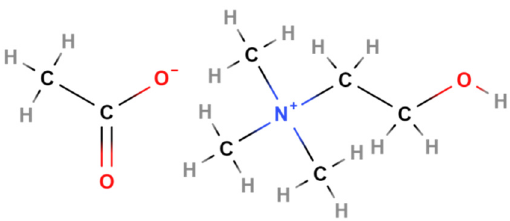
Figure 1. Chemical structure of 2-hydroxyethyl-trimethylammonium acetate [(C 2 H 4 OH)-(CH 3 ) 3 N] [acetate] (choline acetate).